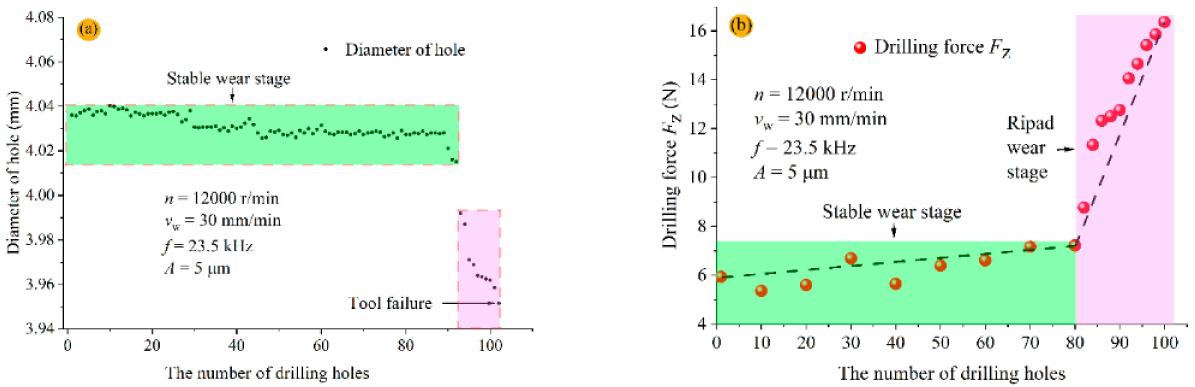
Figure 6. The result of tool life test, ( a ) relationship between the diameter of hole and the number of holes, ( b ) relationship between force and the number of